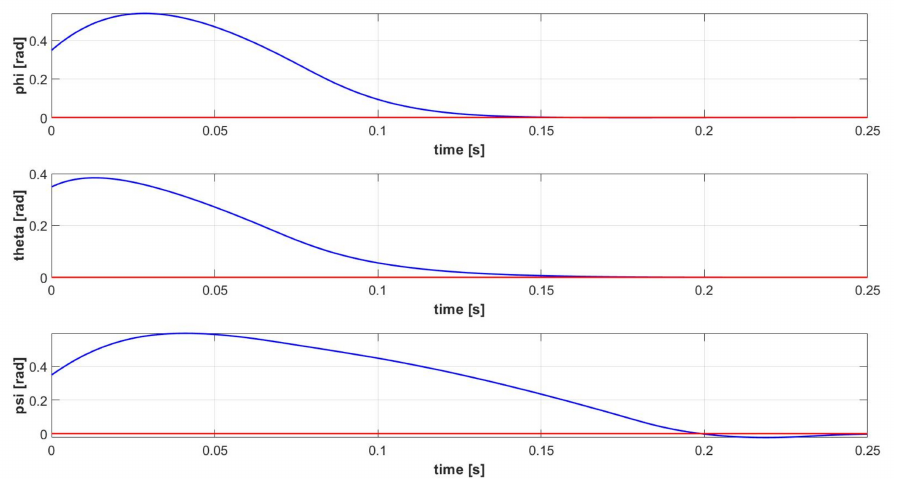
Figure 5. Euler angles signals [ φ ( t ) , ϑ ( t ) , ψ ( t )] of the controlled attitude system (blue): LQR-based Attitude Stabilizer (red).